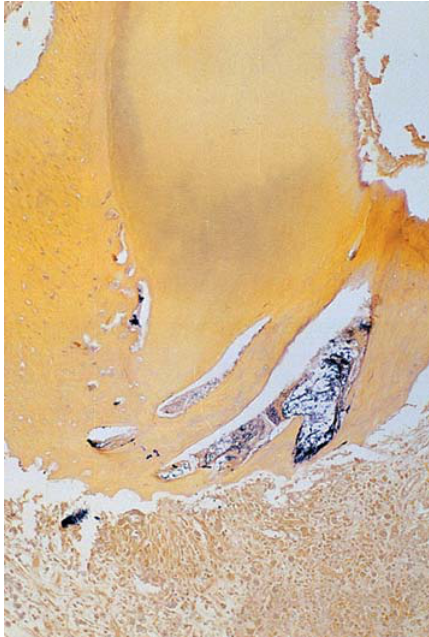
FIGURE 5a- Amplification of Figure 5. Secondary canal densely infected by various microbial morphotypes, Brown & Brenn - 1000X